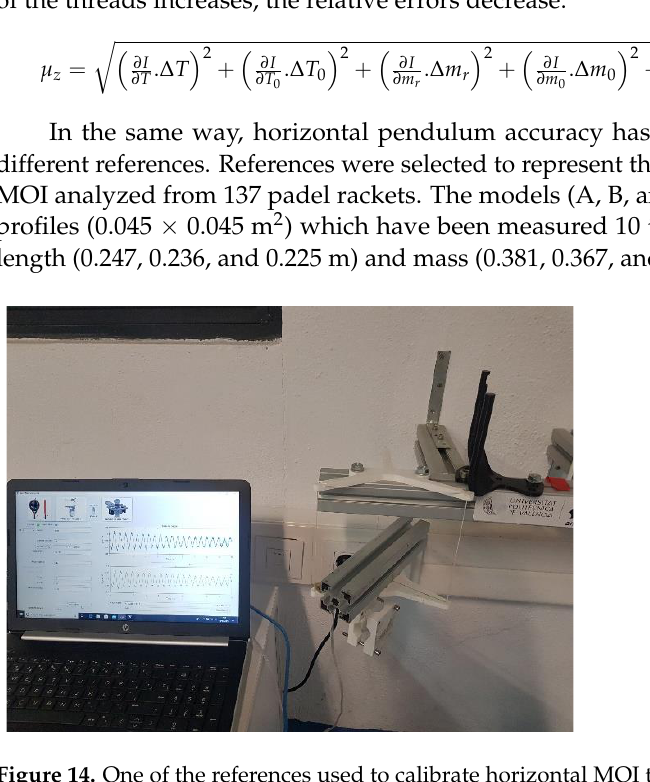
Table 5. Results summary of the references used to calibrate horizontal MOI test stand.